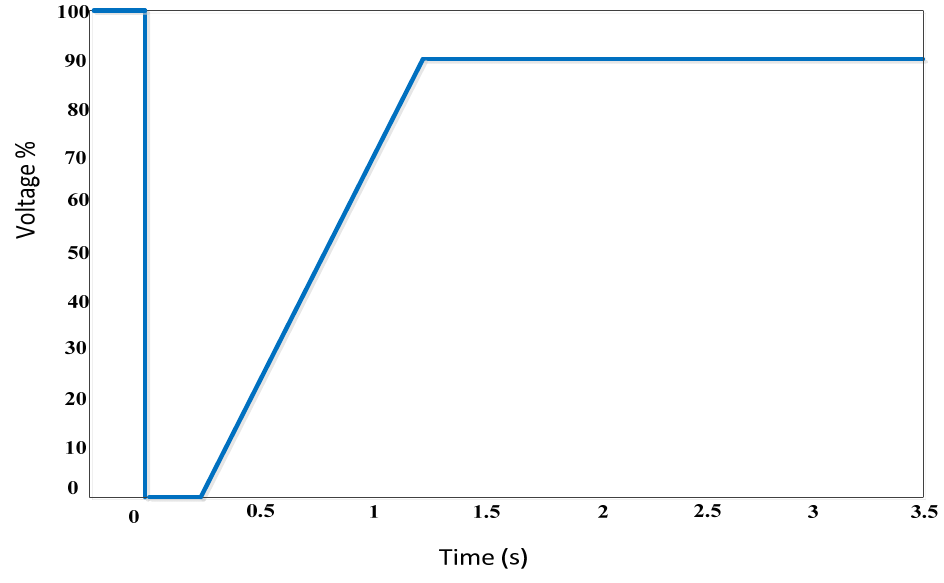
Figure 1. Typical limit curve for FRT requirements.